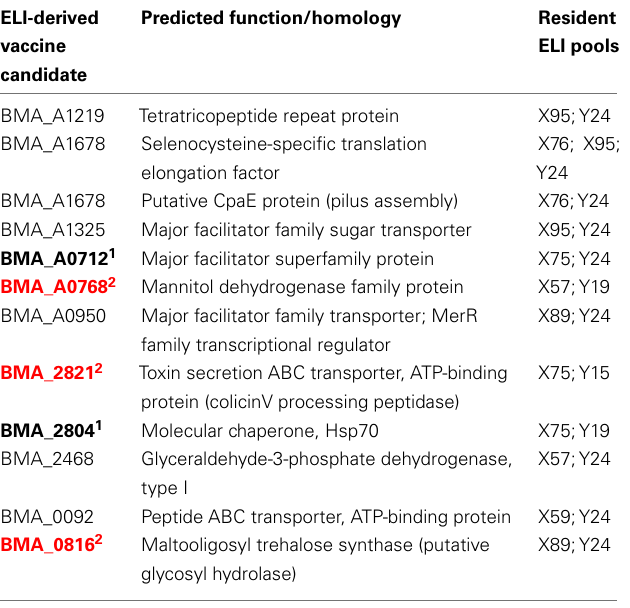
Table 2 | Individual B. mallei vaccine candidate genes identified from matrix analysis of the ELI challenge–protection assays.